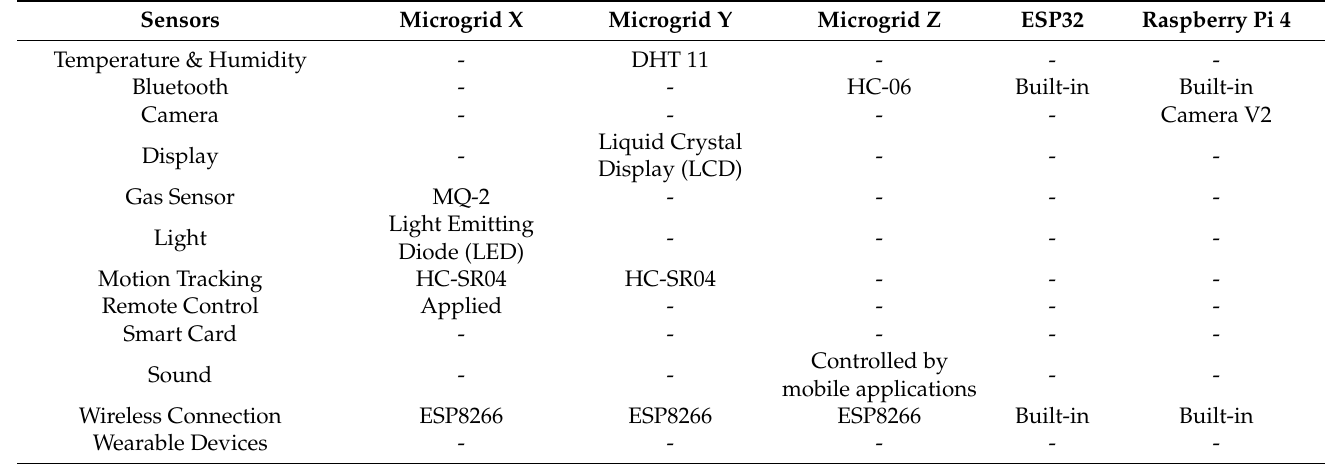
Table 1. Microgrids with sensors and other applied technologies.